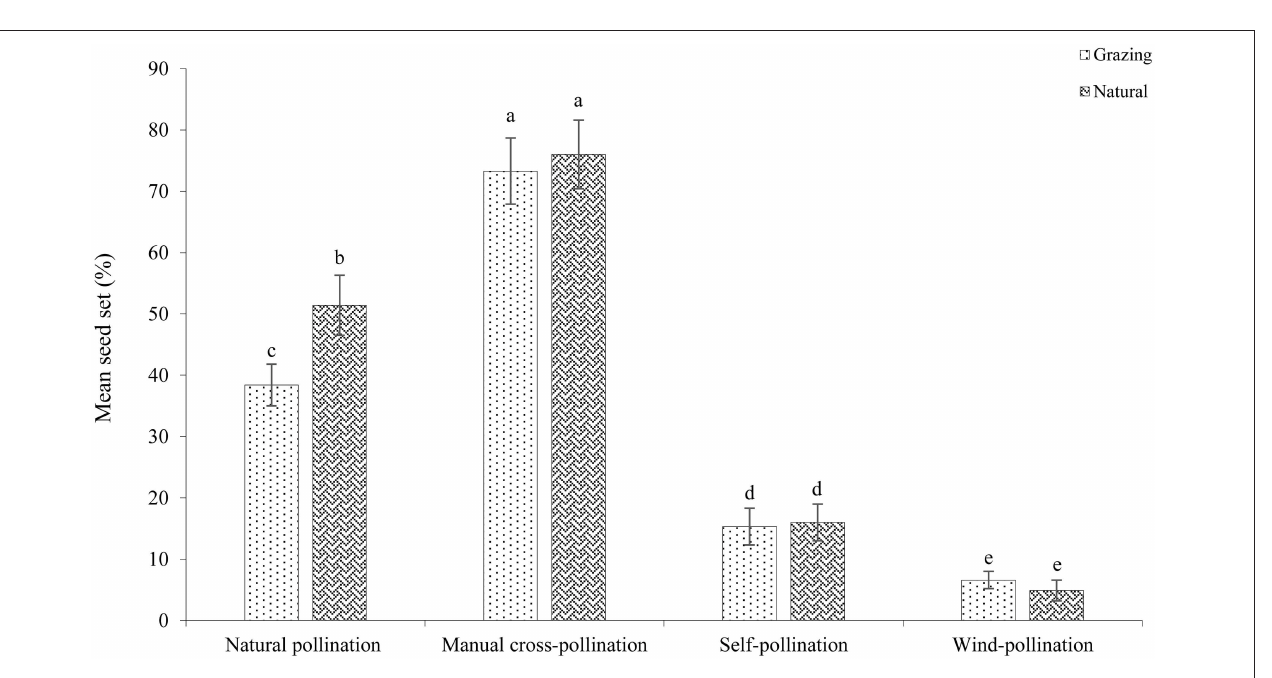
FIGURE 7 | Mean seed set of C. microphylla under different pollination